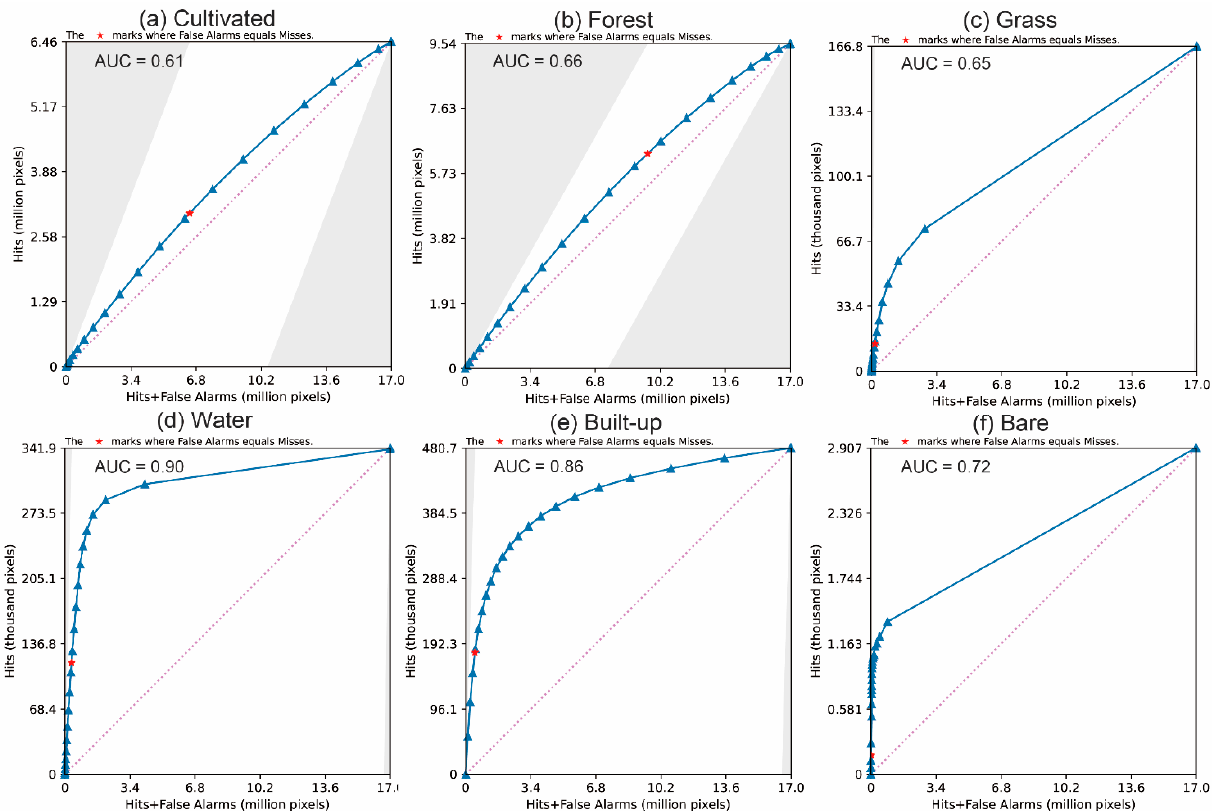
Figure 9. The TOC of simulation in 2015 by category: ( a ) cultivated, ( b ) forest, ( c ) grass, ( d ) water, ( e ) built-up, ( f ) bare.